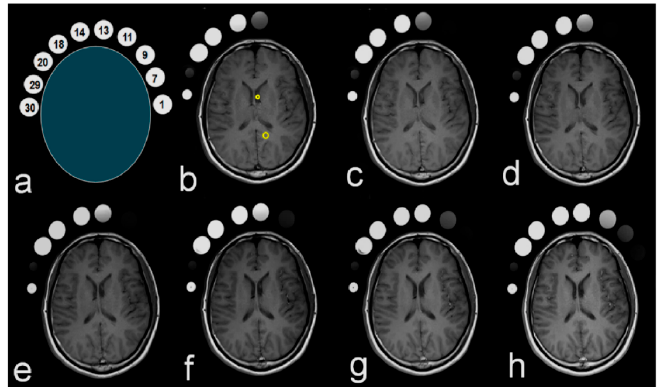
Figure 6. Images of the clinical study. ( a ) container numbers for the clinical phantom; ( b ) changes in SI for a 25 msec TE; ( c ) changes in SI for a 22 msec TE; ( d ) changes in SI for a 19 msec TE; ( e ) changes in SI for a 16 msec TE; ( f ) changes in SI for a 13 msec TE; ( g ) changes in SI for a 10 msec TE; ( h ) changes in SI for a 7 msec TE. SI, signal intensity; TE, echo time.